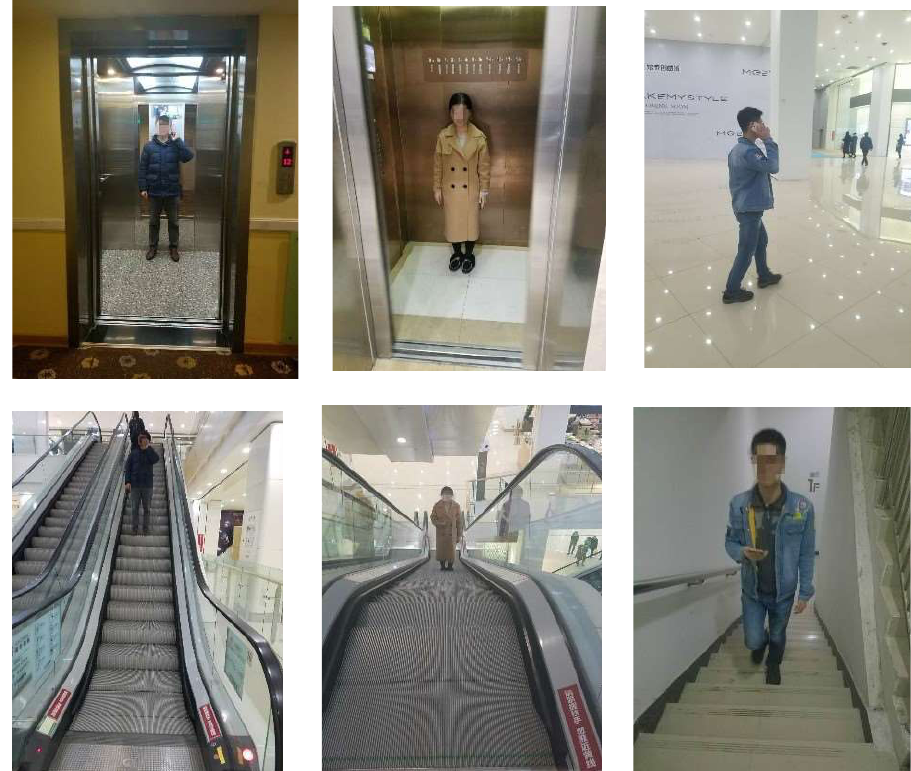
Figure 3. Typical data collection scene. Upper row : elevators 1 and 2 and walking. Lower row : escalators 1 and 2 and going upstairs (from left to right ).